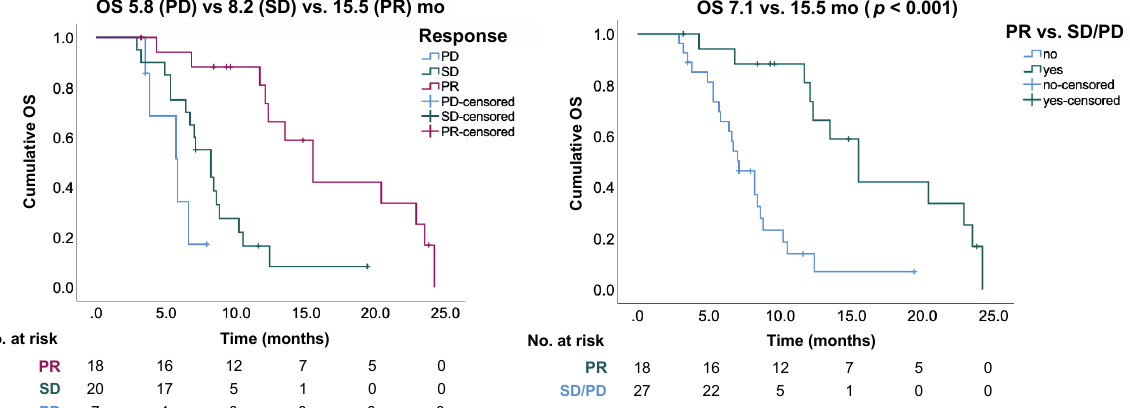
Figure 4. Kaplan–Meier curves ( a ) after 1st and ( b ) 2nd RLT cycle; PFS: progression-free survival, OS: overall survival, PR: partial response, SD: stable disease, PD: progressive disease.